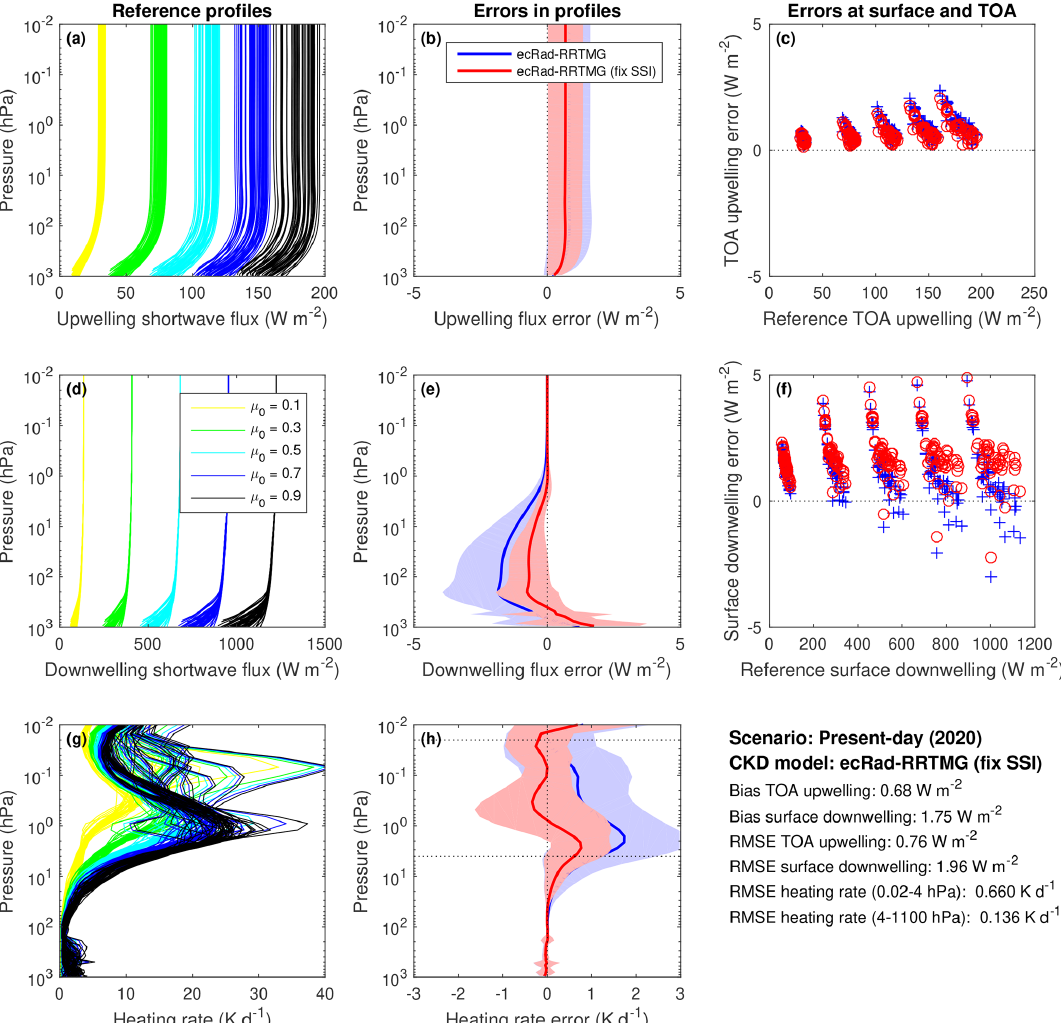
Figure 7. Similar to Fig. 5 but for the shortwave. The reference LBL calculations in panels (a, d, g) are for all 50 Evaluation-1 profiles at five values of the cosine of the solar zenith angle, µ 0 . The subsequent evaluation considers all 250 combinations. The blue lines in (b, e, h) show the unmodified RRTMG, and red shows it after scaling the irradiance profiles in each of the 13 bands in Table 6 to use the same solar irradiance as the reference calculations. Panels (c, f) compare TOA and surface irradiances for the unmodified and modified versions of RRTMG, with the five clusters of points in each panel corresponding to the five values of µ 0